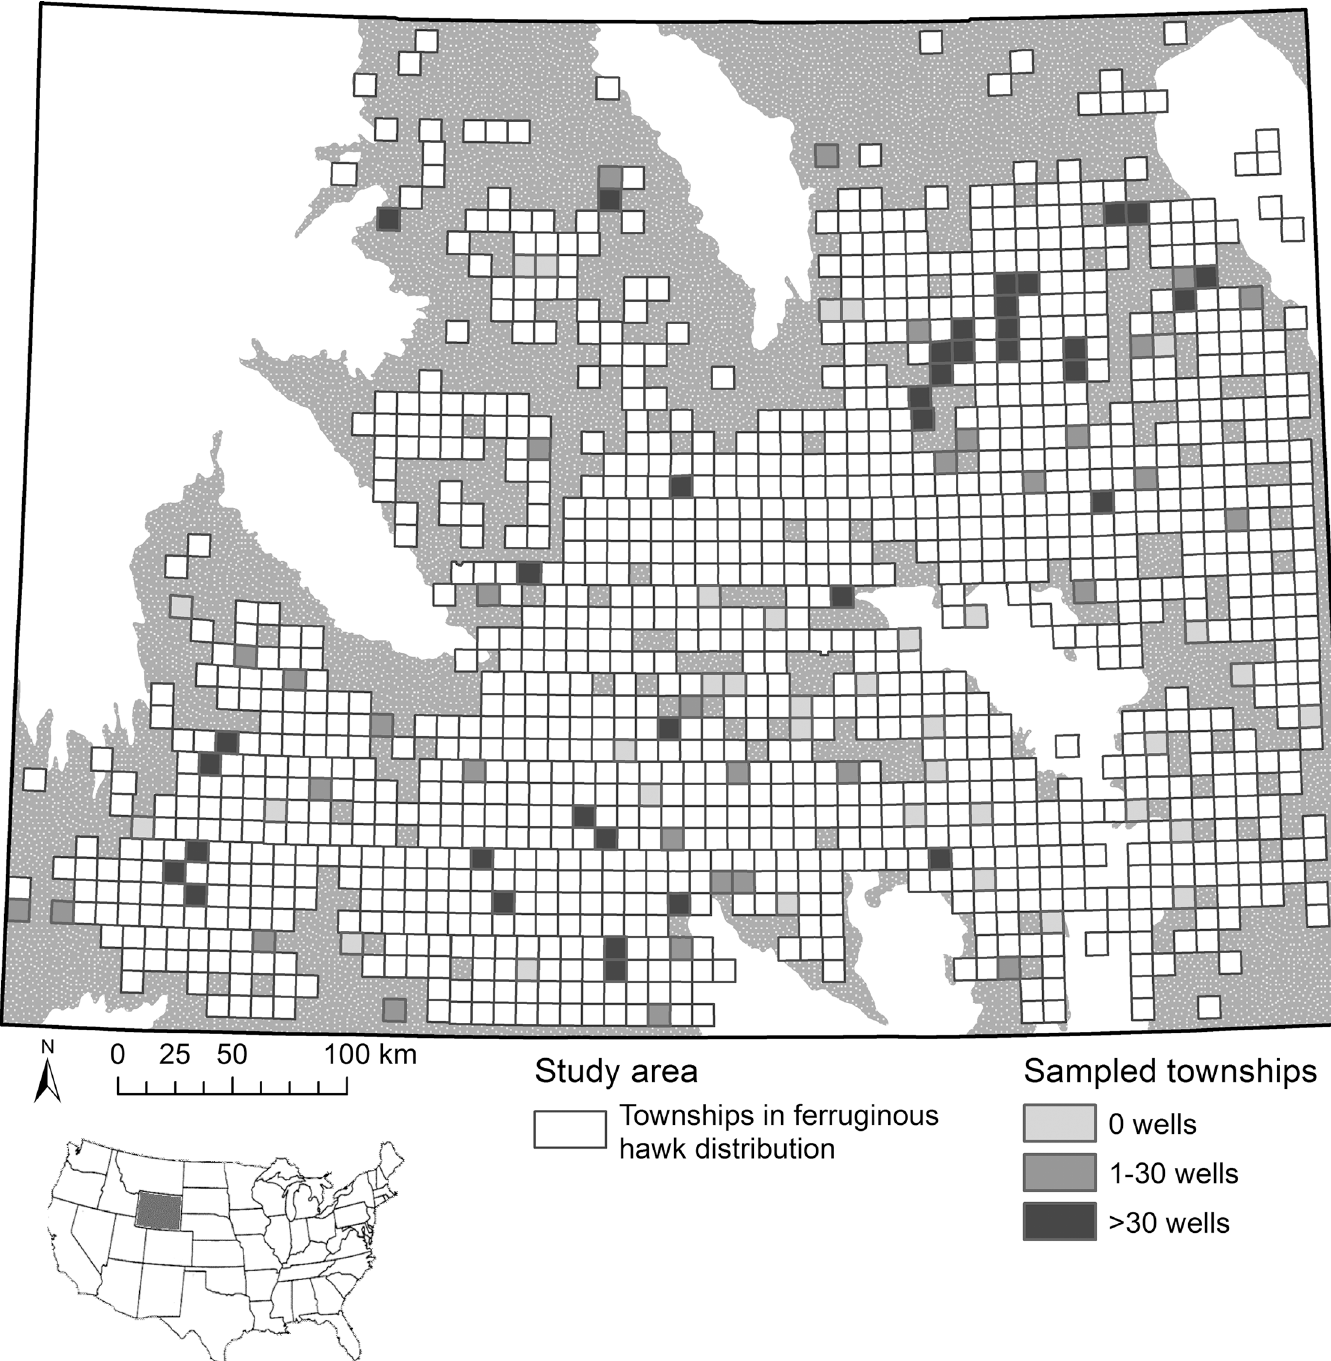
Fig 1. Study area encompassing the distribution of ferruginous hawks in Wyoming, USA. Depicted are Public Land Survey System townships with centroids in the study area and townships sampled for ferruginous hawk nests stratified by 3 levels of oil and gas well density. Grey areas are lowland basins and white areas are mountain ranges. Inset shows the location of Wyoming in the United